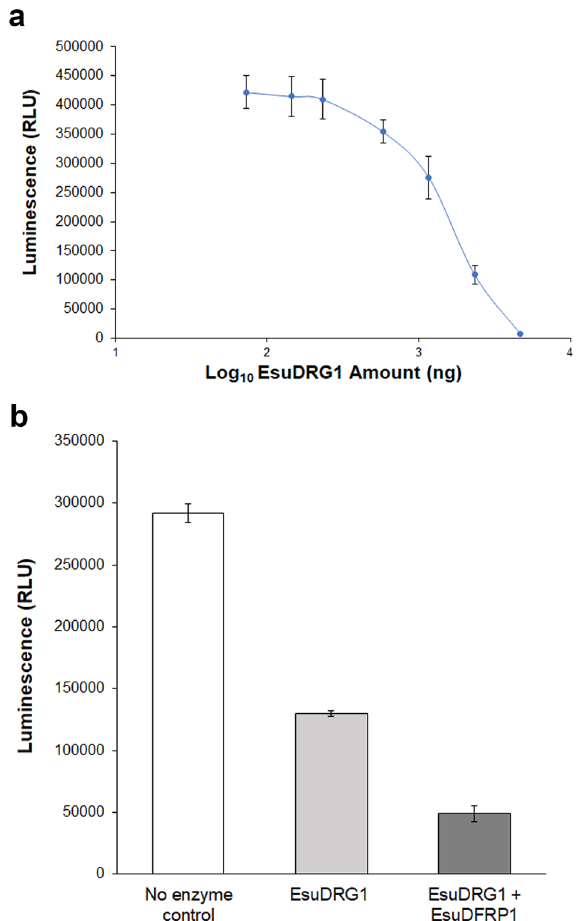
Figure 6. Intrinsic GTPase activity of the sponge DRG1 protein. ( a ) EsuDRG1 was serially diluted in the GTP/ GAP buffer with fixed concentration of GTP (2 µM). Luminescence was measured after two hours. Standard deviations are indicated (mean ± SD, n = 3). RLU, relative luminescence unit. ( b ) DFRP1 promotes catalytic activity of the sponge protein DRG1. Concentration of each protein used in the reactions was 1.2 µM. The control sample contained only the GTP/GAP buffer. Standard deviations are indicated on the